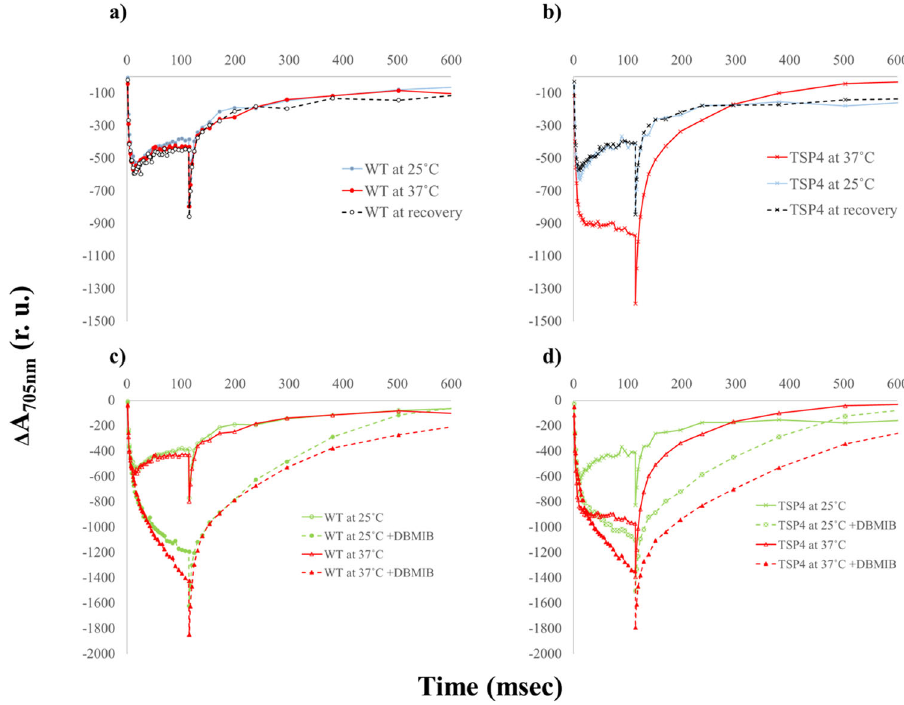
Fig. 1 Light-induced P700 photo-oxidation and P700 + reduction of the WT and TSP4 C. reinhardtii cells. P700 kinetics of the wild-type cells ( a ) and the TSP4 cells ( b ) that were grown overnight at 25 °C (blue), or at non-permissive temperatures of 37 °C (red), which were subsequently transferred back to recover at 25 °C (grey dashed line). P700 kinetics of the wild-type cells ( c ) and the TSP4 cells ( d ) that were grown overnight at 25 °C (green), or at non-permissive temperatures of 37 °C (orange), in the absence or presence of DBMIB (dashed